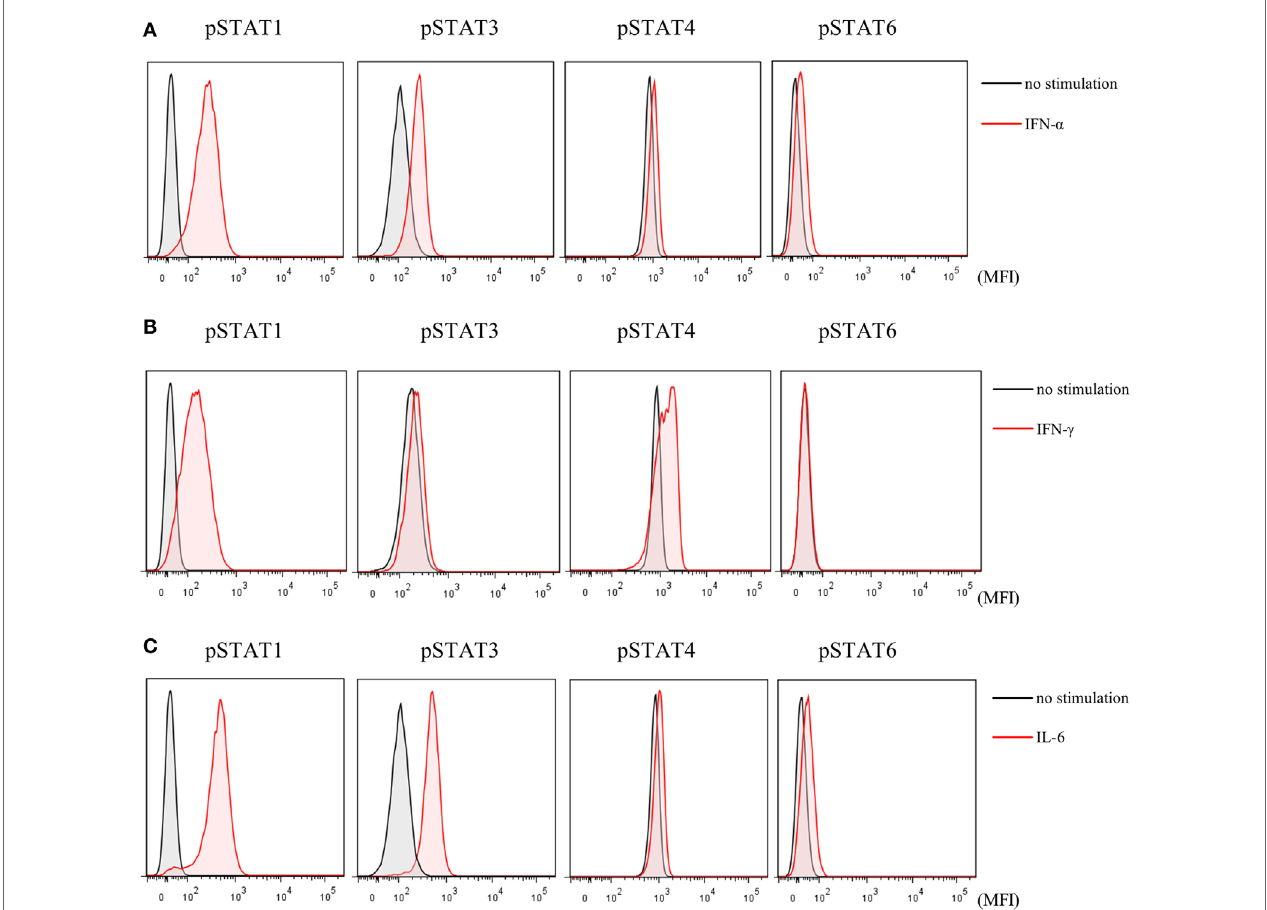
FigUre 6 | Phosphorylation of signal transducer and activator of transcription (STAT) mediated by type-I interferon (IFN), type 2 IFN, and interleukin (IL)-6. Representative flow cytometry plots. (a) Phosphorylation of STATs by IFN- α . (B) Phosphorylation of STATs by IFN- γ . (c) Phosphorylation of STATs by